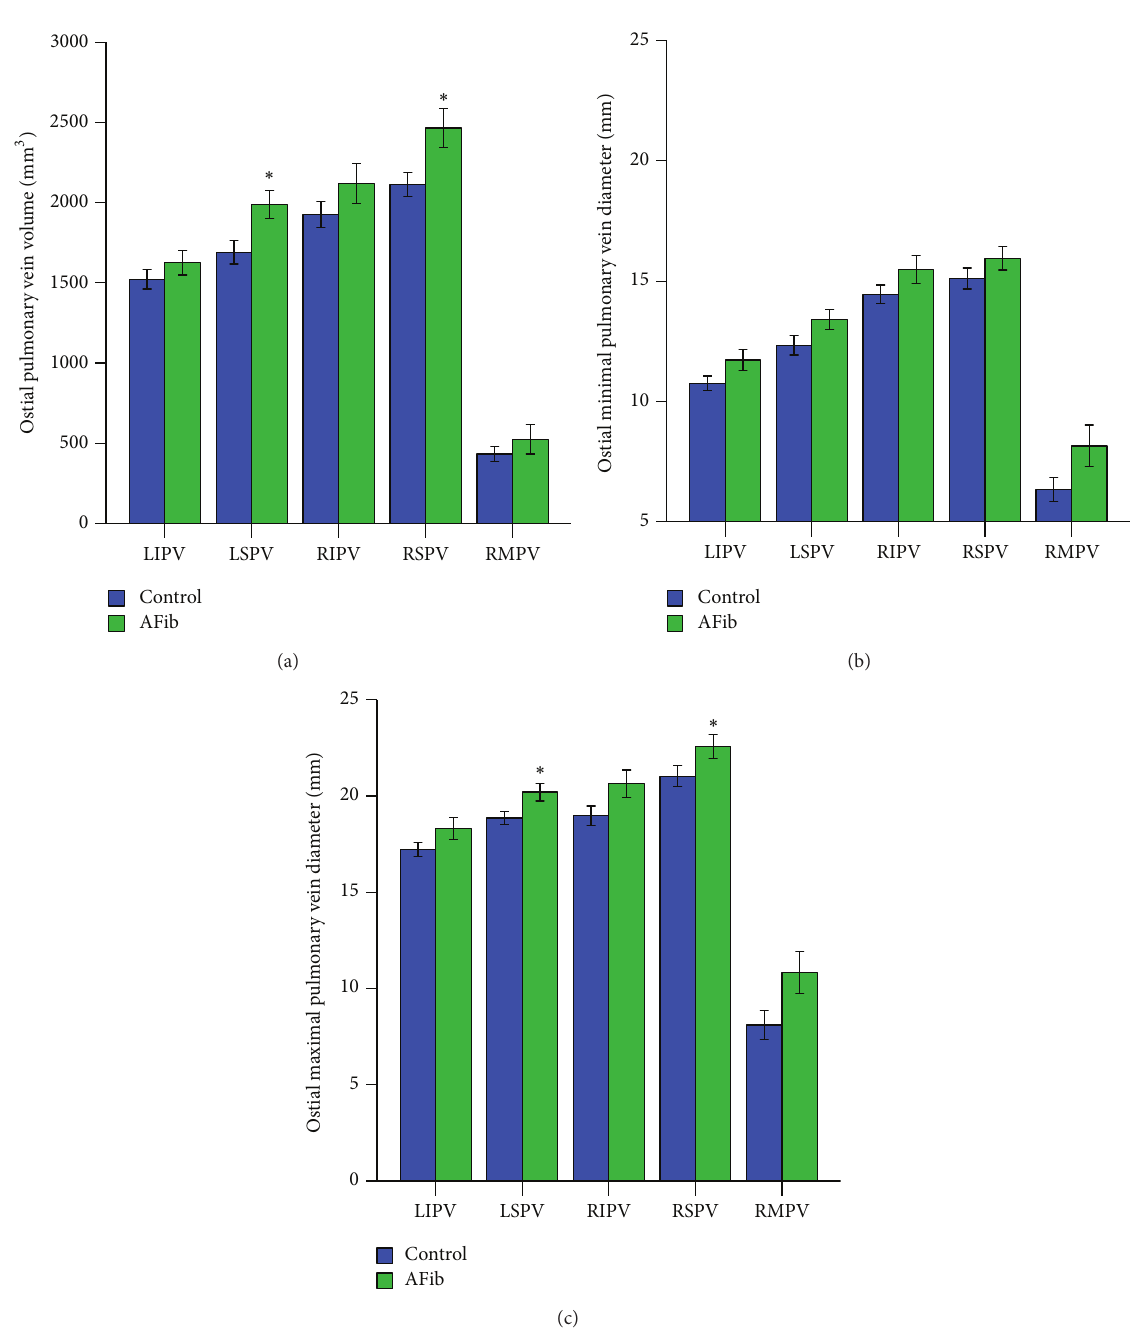
Figure 2: (a) Distribution of pulmonary vein (PV) volume (mm 3 ) in patients with atrial fibrillation (AFib) compared to controls with sinus rhythm (SR). (b) Distribution of minimal pulmonary vein (PV) diameter (mm) in patients with atrial fibrillation (AFib) compared to healthy controls with sinus rhythm (SR). (c) Distribution of maximal pulmonary vein (PV) diameter (mm) in patients with atrial fibrillation (AFib) compared to healthy controls with sinus rhythm (SR). LIPV, left inferior pulmonary vein; LSPV, left superior pulmonary vein; RIPV, right inferior pulmonary vein; RSPV, right superior pulmonary vein; RMPV, right middle pulmonary vein. Data are presented as mean ± SEM; ∗ 𝑃 < 0.05